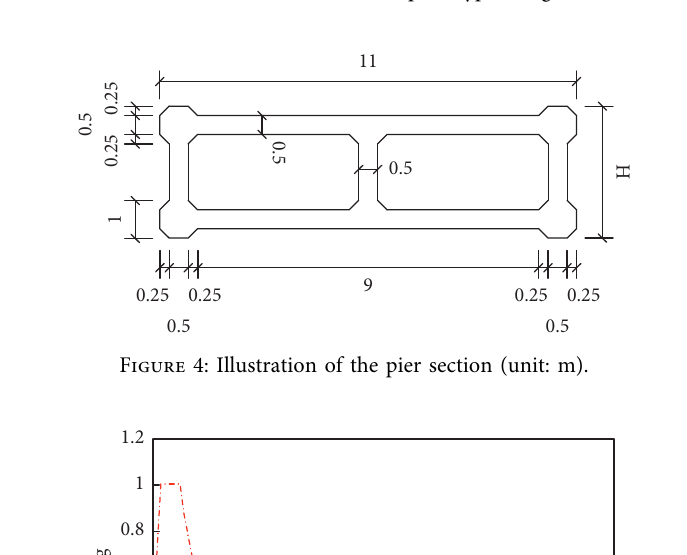
Figure 3: Illustration of the prototype bridge.